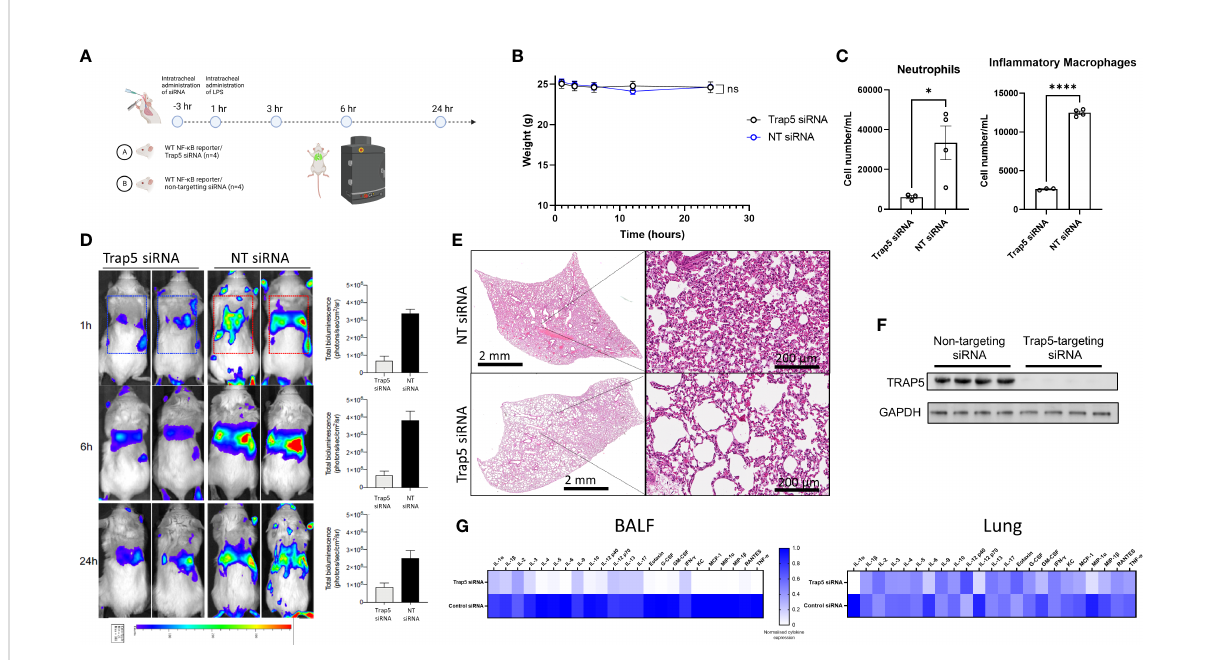
FIGURE 5 Intratracheal administration of Trap5 siRNA decreases the NF- k B response. (A) Experimental layout showing time points at which siRNA and LPS were administered to mice (n=4 per group). (B) Murine weights remained consistent throughout the course of the experiment with some transient weight loss recorded in the NT siRNA group. (C) Murine BALF neutrophils (live dead + /Ly6G + /CD11b + ) and in fl ammatory macrophages (live dead + /Ly6G - /CD11b + /CD11c intermed) were measured using fl ow cytometry. Statistical analysis was performed using student ’ s t -test. * P < 0.05 and **** P < 0.0001. (D) Noninvasive in vivo bioimaging of NF- k B reporter gene expression was performed using the IVIS Spectrum system. Representative images show bioluminescence at 1, 6, and 24 h after intratracheal LPS administration. Data is presented as a bar chart depicting measured bioluminescence intensity emitted from lung region of interest (ROI). Dotted squares represent the region of interest for data analysis. Data are presented as mean ± SEM ( n = 4 mice per group). (E) Representative hematoxylin & eosin staining of murine lungs. Statistical analysis was performed using student ’ s t -test (* P < 0.05; **** P < 0.0001). (F) Immunoblotting of murine lung homogenate. (G) Heatmap of murine BALF and lung cytokines from 23-plex analysis (cytokine values were mean normalized; high values-blue; low